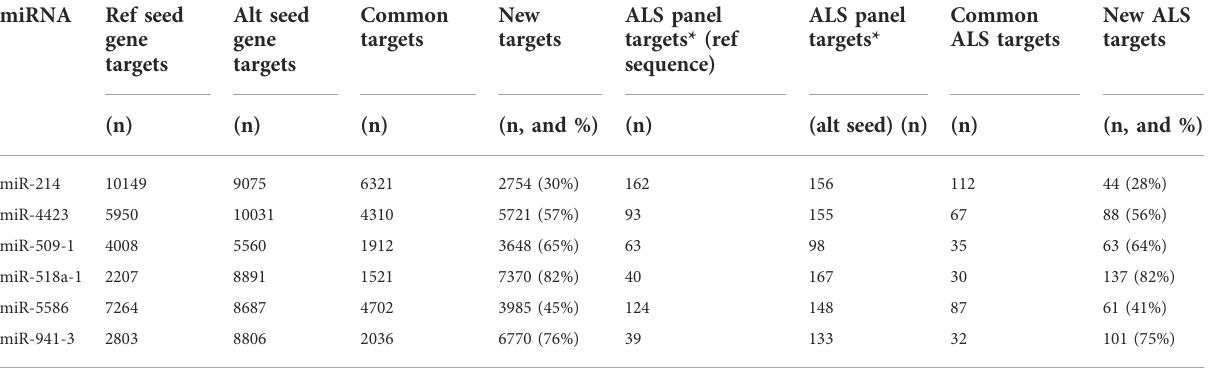
TABLE 5 Prediction of target genes of miRNAs with variants in the seed sequence.